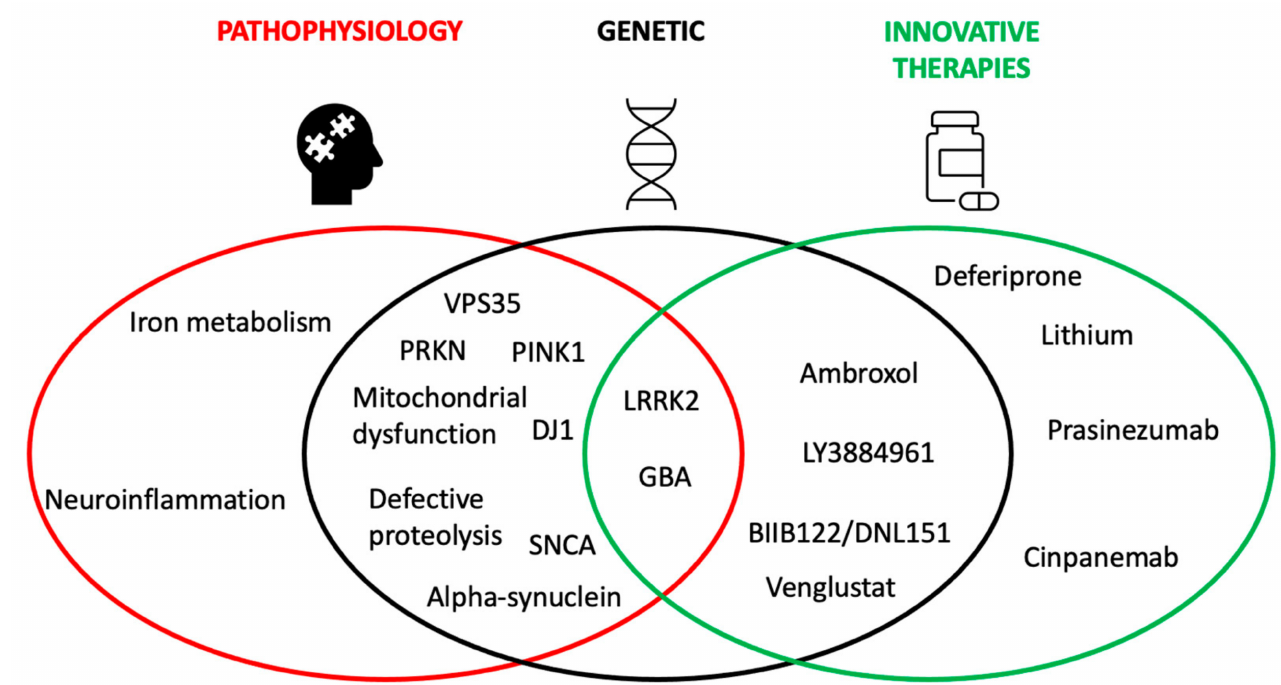
Figure 1. Interplay between genetic contributions to PD, pathophysiology, and innovative thera- pies. The importance of the genetic contribution to PD pathogenesis is twofold. From one side, the identification of genetic variants that can cause or increase the risk of PD can elucidate the different pathophysiological mechanisms involved in the disease. From another side, this knowledge can help better investigate potentially effective treatments and explore new personalized therapies. As an example, mutations in the GBA or LRRK2 genes have led to a better understanding of PD pathophys- iology but also to the development of innovative experimental therapies (i.e., ambroxol, venglustat, BIIB122/DNL151, LY3884961). On the other hand, DJ1, PINK,1 and SNCA have allowed us to improve our knowledge about the underlying pathophysiology of PD but until now no experimental treatments specifically targeting these genes have been developed. Some other innovative therapies, such as prasinezumab, cinpanemab, deferiprone and lithium, are not focused on the genetic aspects of the disease but on the common pathophysiological mechanisms of PD. Abbreviations: glucocere- brosidase: GBA; leucine-rich repeat kinase 2: LRRK2; Parkin: PRKN; PTEN Induced Kinase-1: PINK1; VPS35: Vacuolar protein sorting ortholog